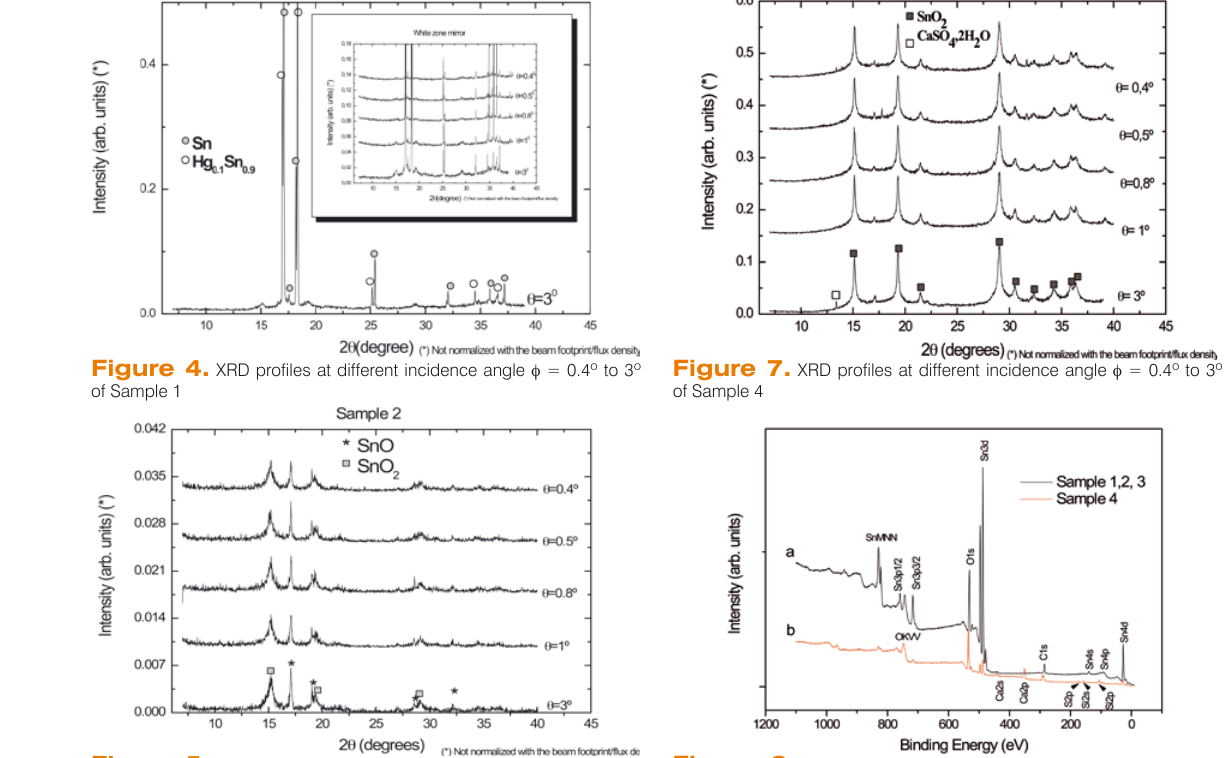
Figure 5. XRD profiles at different incidence angle φ = 0.4º to 3º of Sample 2